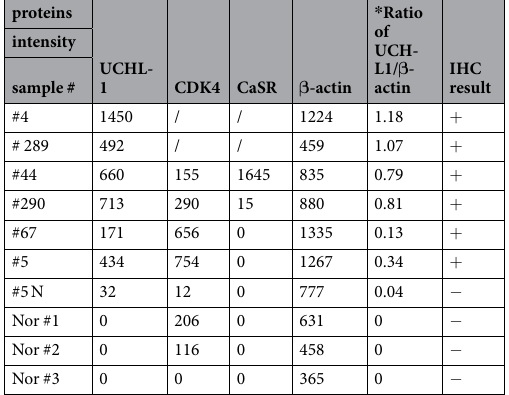
Table 3. Quantification of UCH-L1 protein expression in tumors and their paired tissues on western blot. * The ratio of UCH-L1/ β -actin in 6 tumor specimens (#4, #289, #44, #290, #67 and #5) was significantly higher than that in paired tissue (#5 N) or other normal pancreatic tissues (Nor 1, 2, 3), median 0.8 (0.13–1.18) vs. 0 (0–0.04), p = 0.0095, Mann-Whitney U test. The results from western blot are comparable with that from immunohistochemical (IHC) staining.